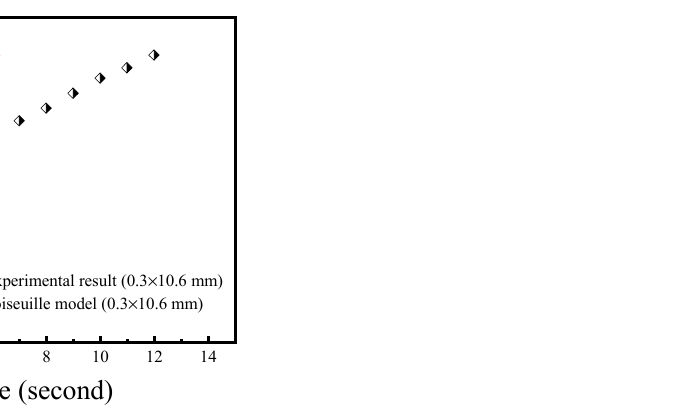
( b ) Figure 5. ( a ) Diagram of the imbibition distance as a function of time in water-displacing-oil exper- iments in circular single channels. ( b ) Diagram of the imbibition rate as a function of time. (Three of the four sets of experiment data specified in ( a ) are selected randomly for the subsequent fitting analysis, and the remaining one set of data thereof is for verification on fitting steps, as indicated in ( b )). Figure 5 shows that the imbibition rate is in the same tendency in several groups of imbibition experiments in which the lower-viscosity DI-water displaces the higher-viscos- ity kerosene, that is, the imbibition rate gradually decreases during spontaneous imbibi- tion, and increases with the increase of diameter of single channel, of which the effect on imbibition rate is widely known. Figure 5a also shows that in the single channel with the same diameter, the length has a great influence on imbibition rate, which is caused by the